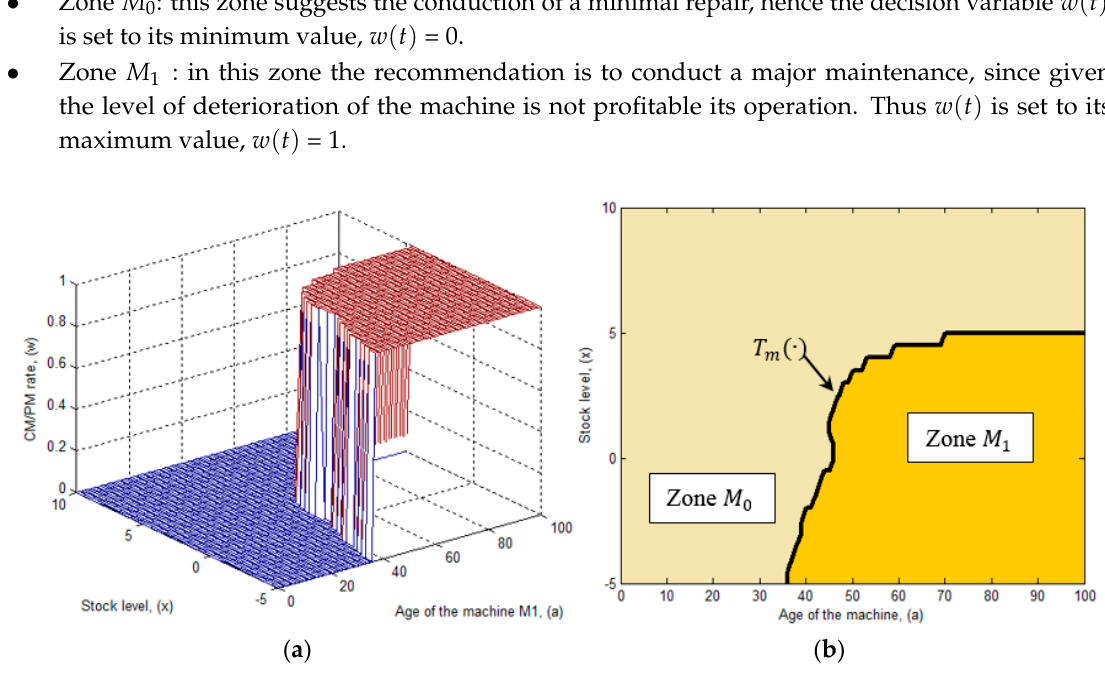
Figure 6. Repair/major maintenance switching policy. ( a ) Repair/major maintenance rate; ( b ) Trace of the repair/major maintenance policy. of the repair/major maintenance